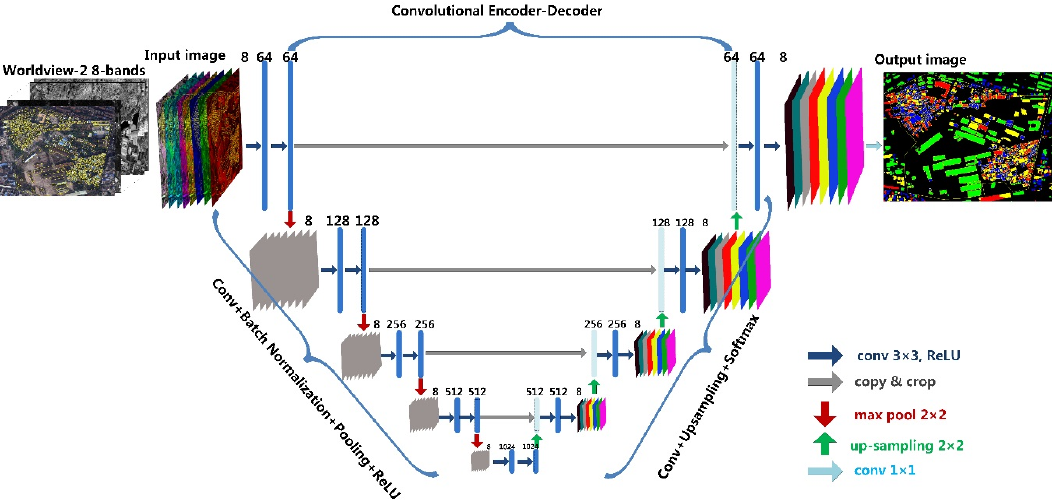
Figure 2. Illustration of the U-net Architecture for semantic segmentation, including the name and function of each layer (modified from Ronneberger et al. [33]).